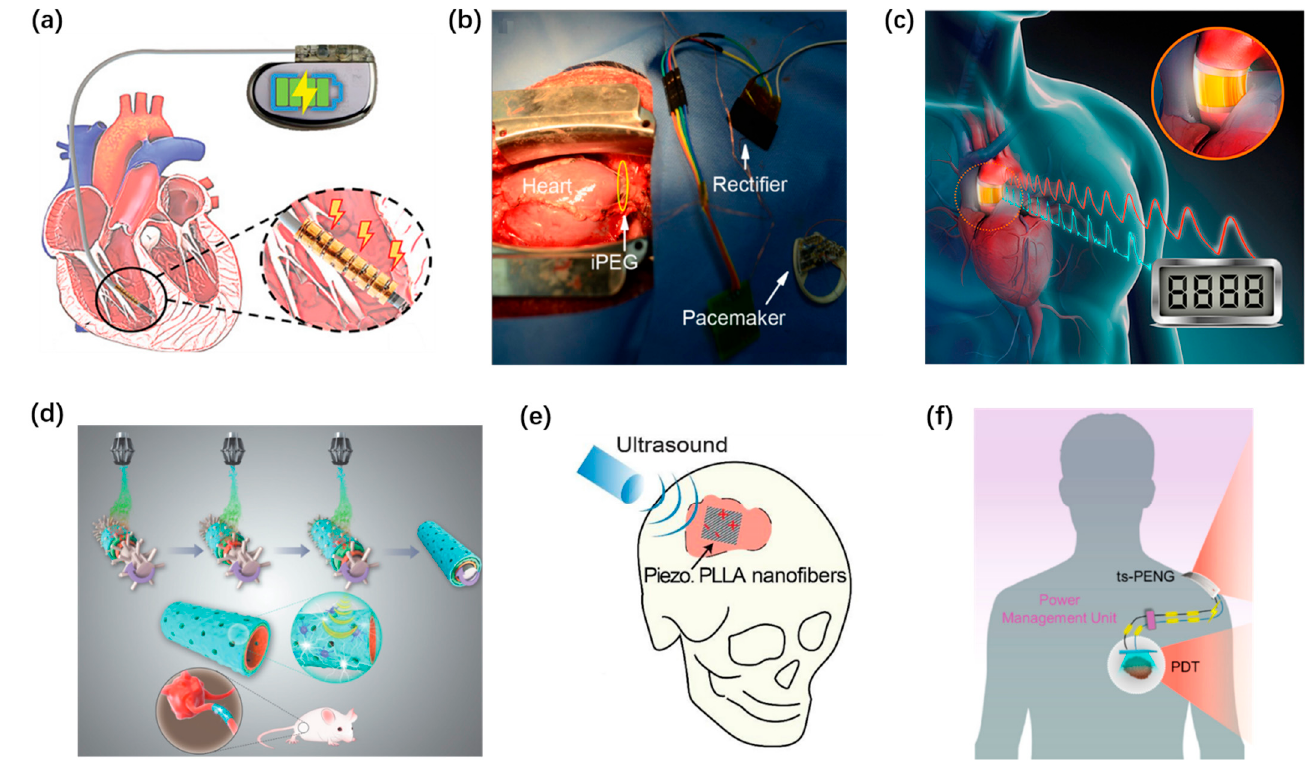
Figure 9. Self-powered implantable systems based on PENG. ( a ) A kirigami inspired PENG. Reproduced with permission from Ref. [97]. Copyright © 2021, Wiley-VCH. ( b ) A self-powered leadless cardiac pacemaker. Reproduced with permission from Ref. [106]. Copyright © 2019, American Chemical Society. ( c ) PENG for in vivo blood pressure monitoring.